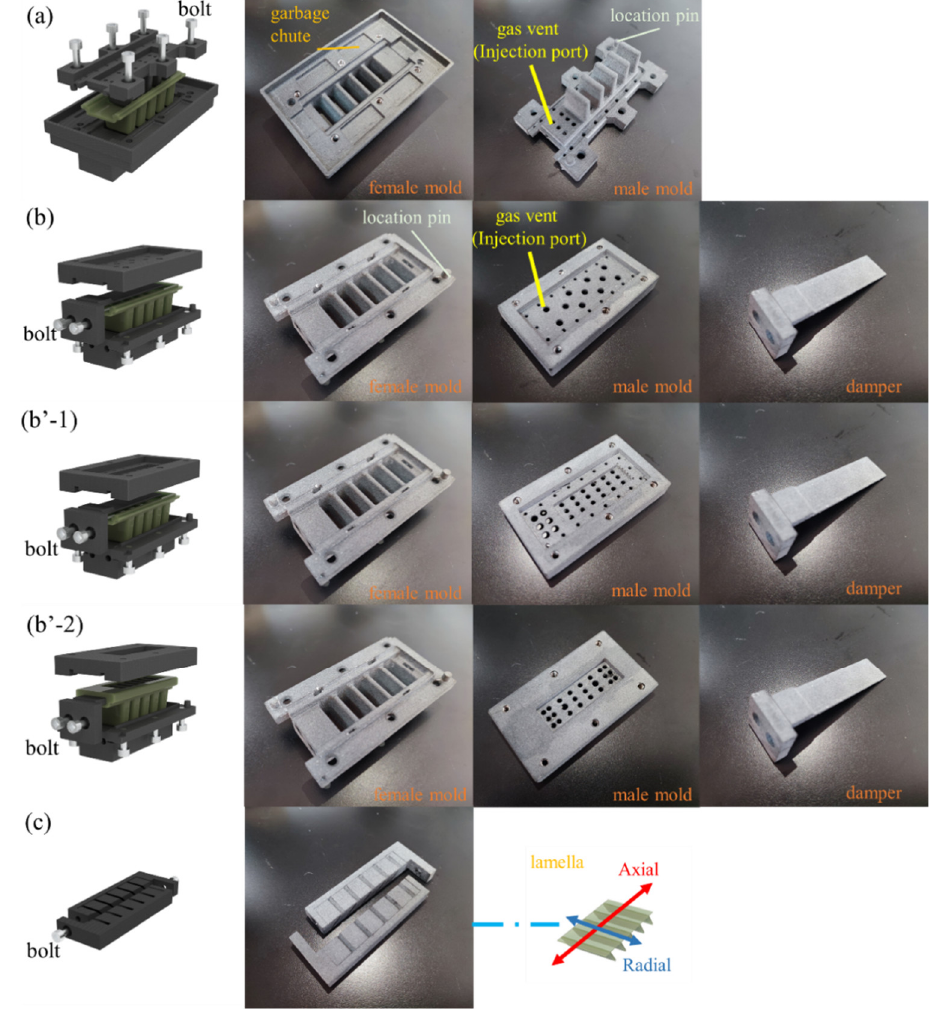
Figure 4. Exploded and physical diagrams of mold: ( a ) upper cavity fold molds; ( b ) lower cavity abdomen molds (unembedded objects); ( b’-1 ) first set of lower cavity abdomen molds (embedded objects); ( b’-2 ) second set of lower cavity abdomen molds; and ( c ) flap molds.